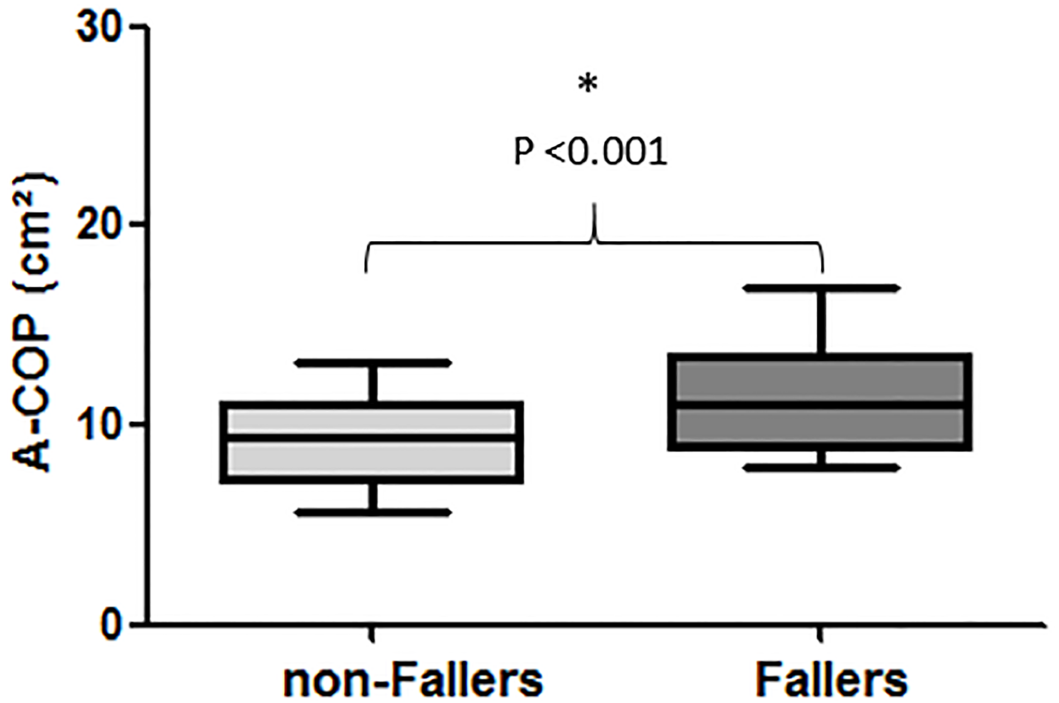
Fig 1. Comparison between groups (non-fallers and fallers) for the area of center of pressure (A-COP)